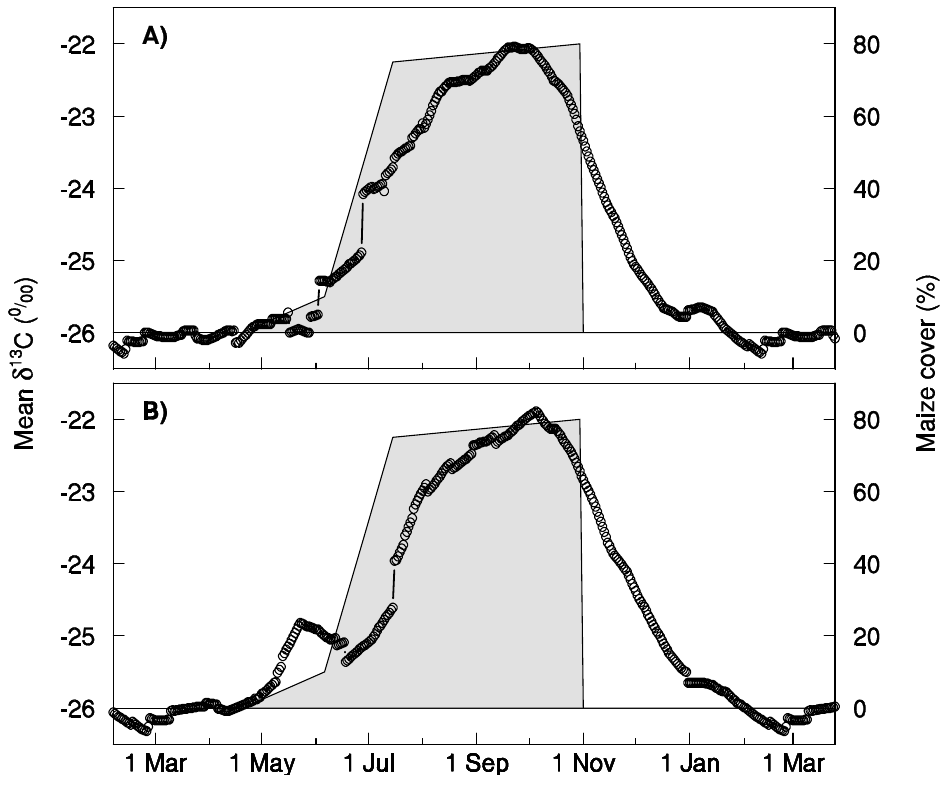
Figure 4. Daily mean δ 13 C in hoof keratin (circles) versus time averaged over 17 animals hunted between mid-February and mid-May. Mean SE for 17 animals is 0.44‰. Average development of maize cover (shaded area) within the research region was taken from [22]. In ( A ) time was derived from the distance to the periople, a relative growth rate of 0.365%/day and the date of hunting; a half-life of 12 day was subtracted. In ( B ) time was derived from the distance to the periople, an absolute growth rate of 0.122 mm/day and the date of hunting; a half-life of 12 day was subtracted.